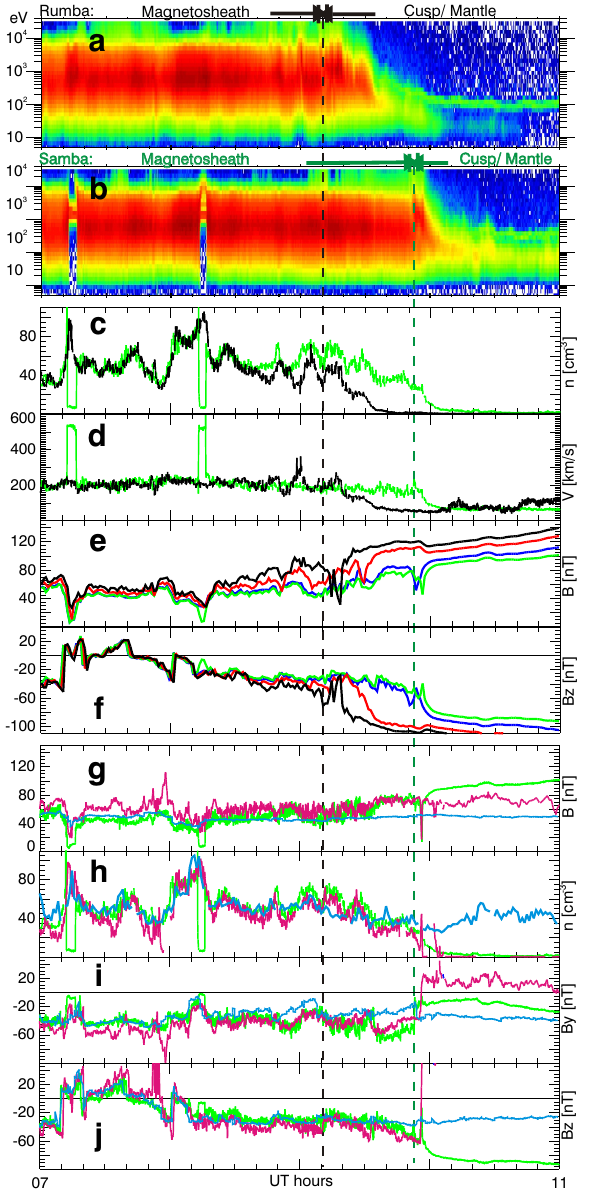
Figure 2 Fig. 2. Satellite plasma and magnetic field observations for 2 February 2003, 07:00–11:00 UT. Panels (a) and (b) show omni- directional energy-time spectrograms for Rumba and Samba. In panels (c) - (f) the four colors represent Rumba (black), Salsa (Red), Samba (green), and Tango (blue). Panels (c) and (d) show ion num- ber density and velocity and panels (e) and (f) show magnetic field strength and GSM Z-component. In panels (g) - (j) green represents Samba, magenta Polar, and cyan ACE. Panel (g) dispalys magnetic field strength (multiplied by a factor 4 for ACE), panel (h) displays number density (multiplied by a factor 4 for ACE and 30 for Polar) and panels (i) and (j) show GSM Y and Z-components of the mag- netic field (multiplied by a factor 4 for ACE). A delay of 50min has been applied to the ACE data. The two vertical lines mark the approximate times of magnetopause entry for Rumba (black) and Samba (green).